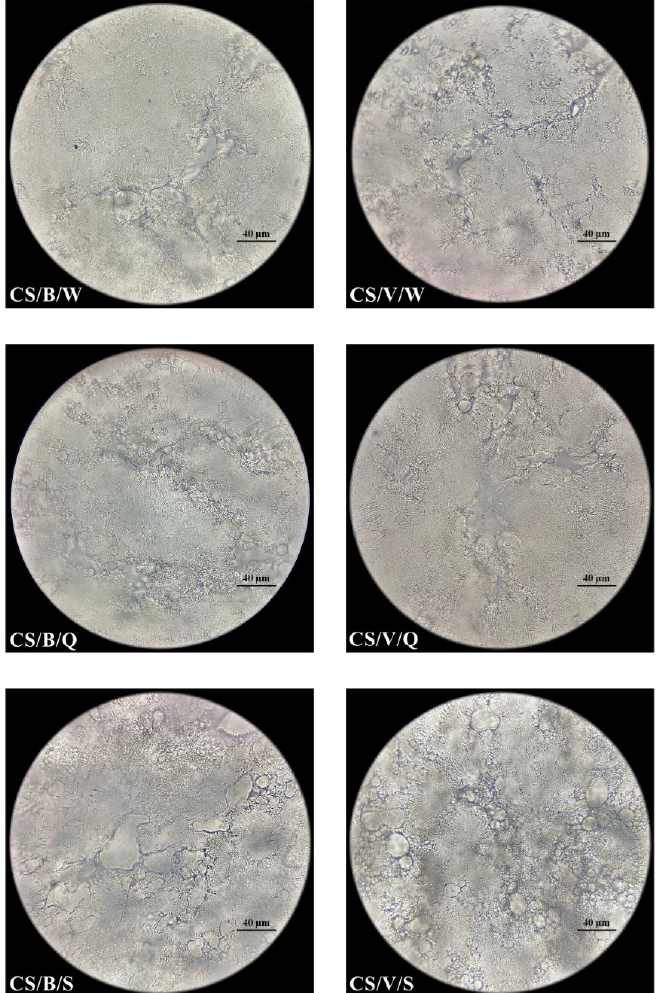
Figure 2. Microstructures of pasta filata cheeses from mixture of cow’s and sheep’s milk (optical microscopy, 1000× objective); Milk (used in cheese production): CS: cow’s and sheep’s milk in pro- portion 70:30; Packaging (method): B: Packed with brine; V: Vacuum packed; Fragmentation